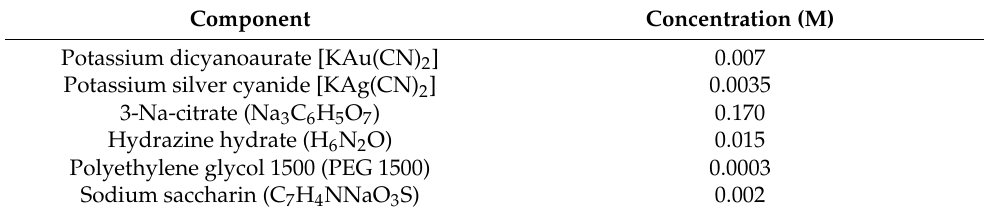
Table 5. The laboratory-developed bath for Au-Ag electroless deposition (KOH, pH = 12), molar ratio [Ag]/[Au] in solution